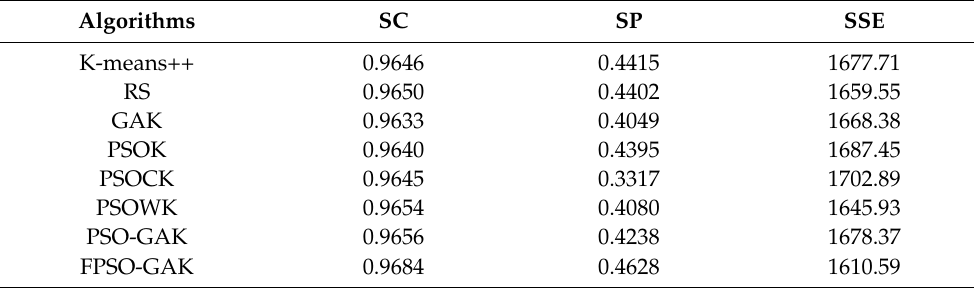
Table 8. Average evaluation indexes of 8 algorithms in multi-source